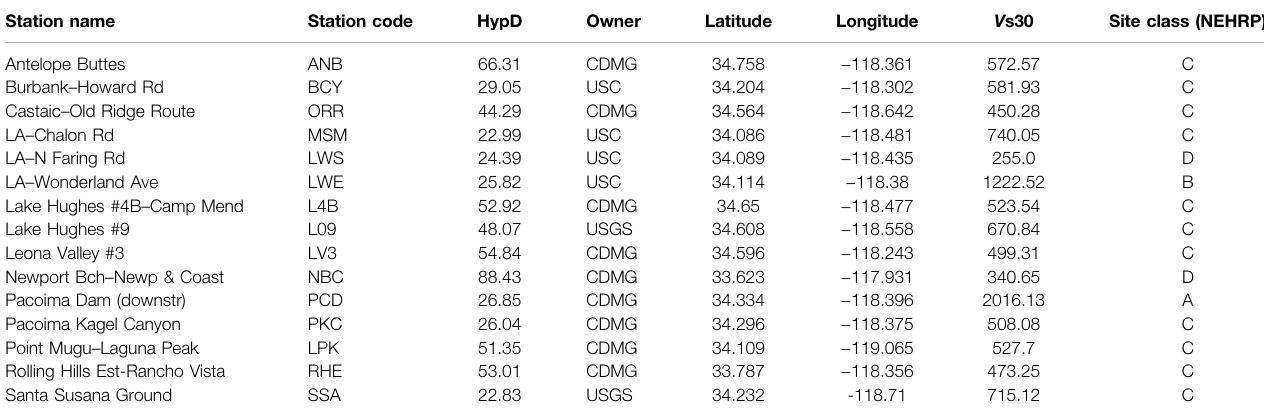
TABLE 4 | Information on strong motion observation stations of the Northridge earthquake (Dang et al., 2020). Station